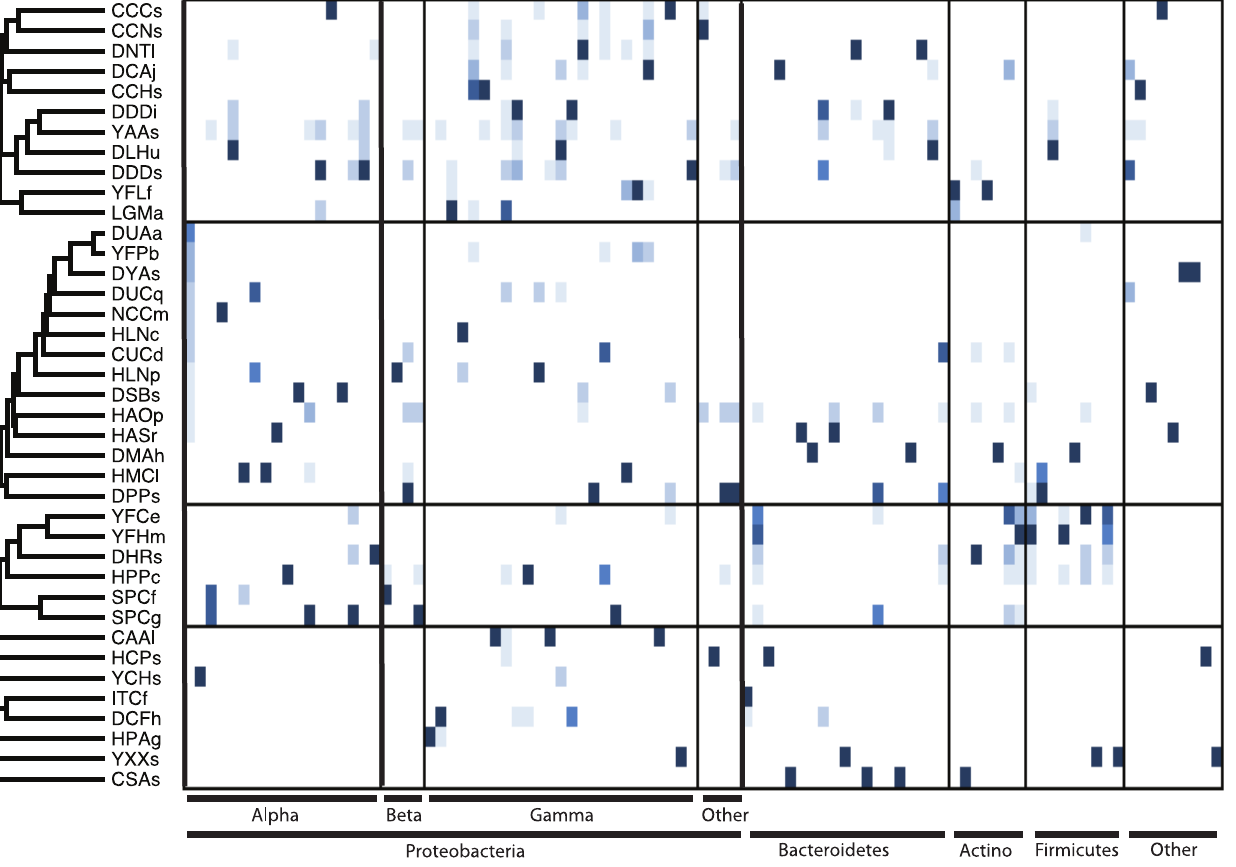
Figure 2. Bray-Curtis cluster of insect species based on their associated bacterial communities (all 477 bacterial phylotypes used for Bray-Curtis analysis) and Z-scores of the 96 most abundant bacterial phylotypes with lowest scores in light blue and highest scores in dark blue. Each column is a unique bacterial phylotype. Phylotypes are arranged according to taxonomic classification. Insect species are identified by a four-letter code (Table 1) with the first letter indicating the order, as follows: (C) Coleoptera, (D) Diptera, (H) Hemiptera, (I) Isoptera, (L) Lepidoptera, (N) Neuroptera, (S) Siphonoptera, and (Y) Hymenoptera. doi:10.1371/journal.pone.0061218.g002 PLOS ONE |